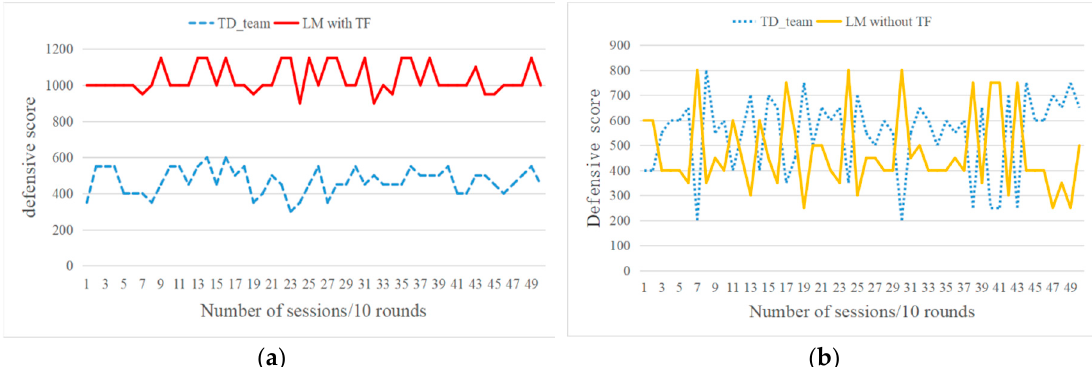
Figure 16. Comparisons of learning models in score ratio. One model uses transfer learning, the other does not use transfer learning.